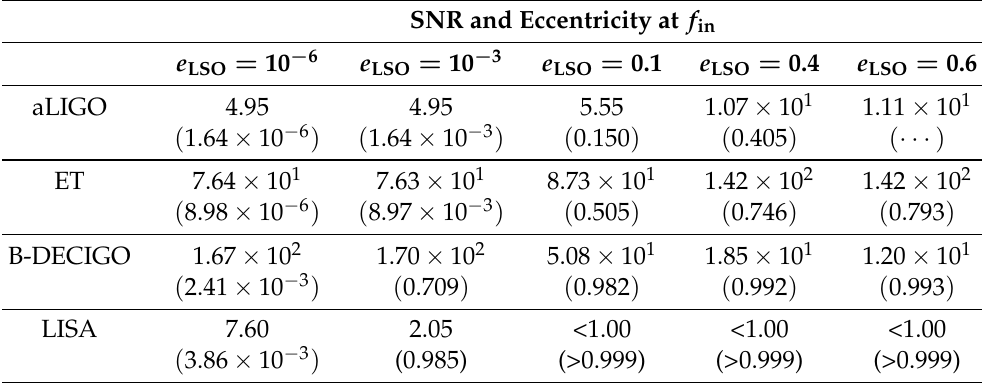
Table A1. Averaged SNRs ρ ave of the GW190521-like, non-spinning, eccentric BBHs accumulated in each band five years prior to coalescence, for given values of final eccentricity e = e LSO . We ) = ( 102 M (cid:12) , 102 M (cid:12) ) , and the luminosity assume the source-frame component masses ( m r , m r 2 1 distance D L = 1.9Gpc (i.e., the redshift z ∼ 0.35) [44]. The values in parentheses indicate the ‘initial’ eccentricity estimated from the initial GW frequency ( f in defined in Section 3) of the second harmonic mode in each detectors. Note that aLIGO’s ‘initial’ eccentricity when e LSO = 0.6 is not displayed because the second harmonic mode is not detectable in this